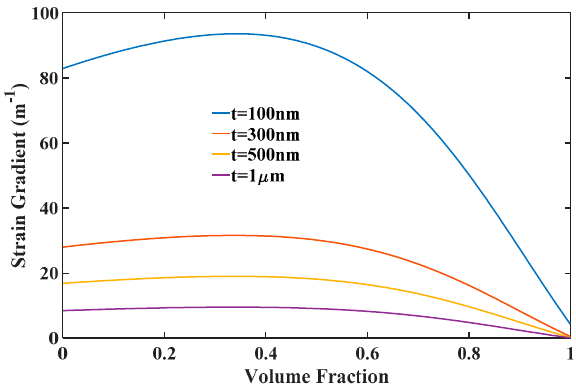
Figure 6. The strain gradient varied with volume fraction of the FE material.